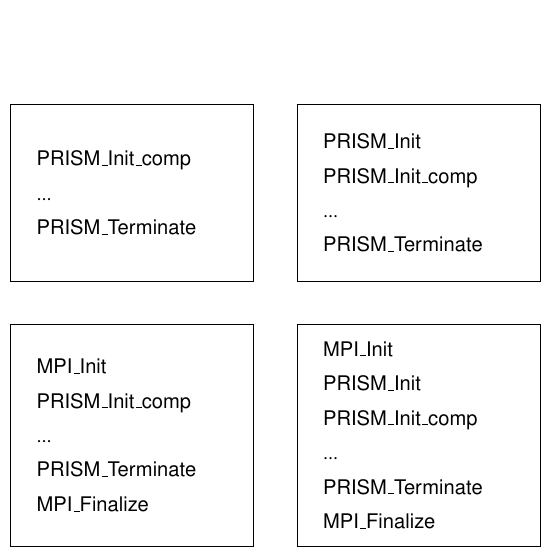
Fig. 1. The four allowed sequences of calls for initializing and terminating an ESM component for coupling with OASIS4 and its relation to MPI.